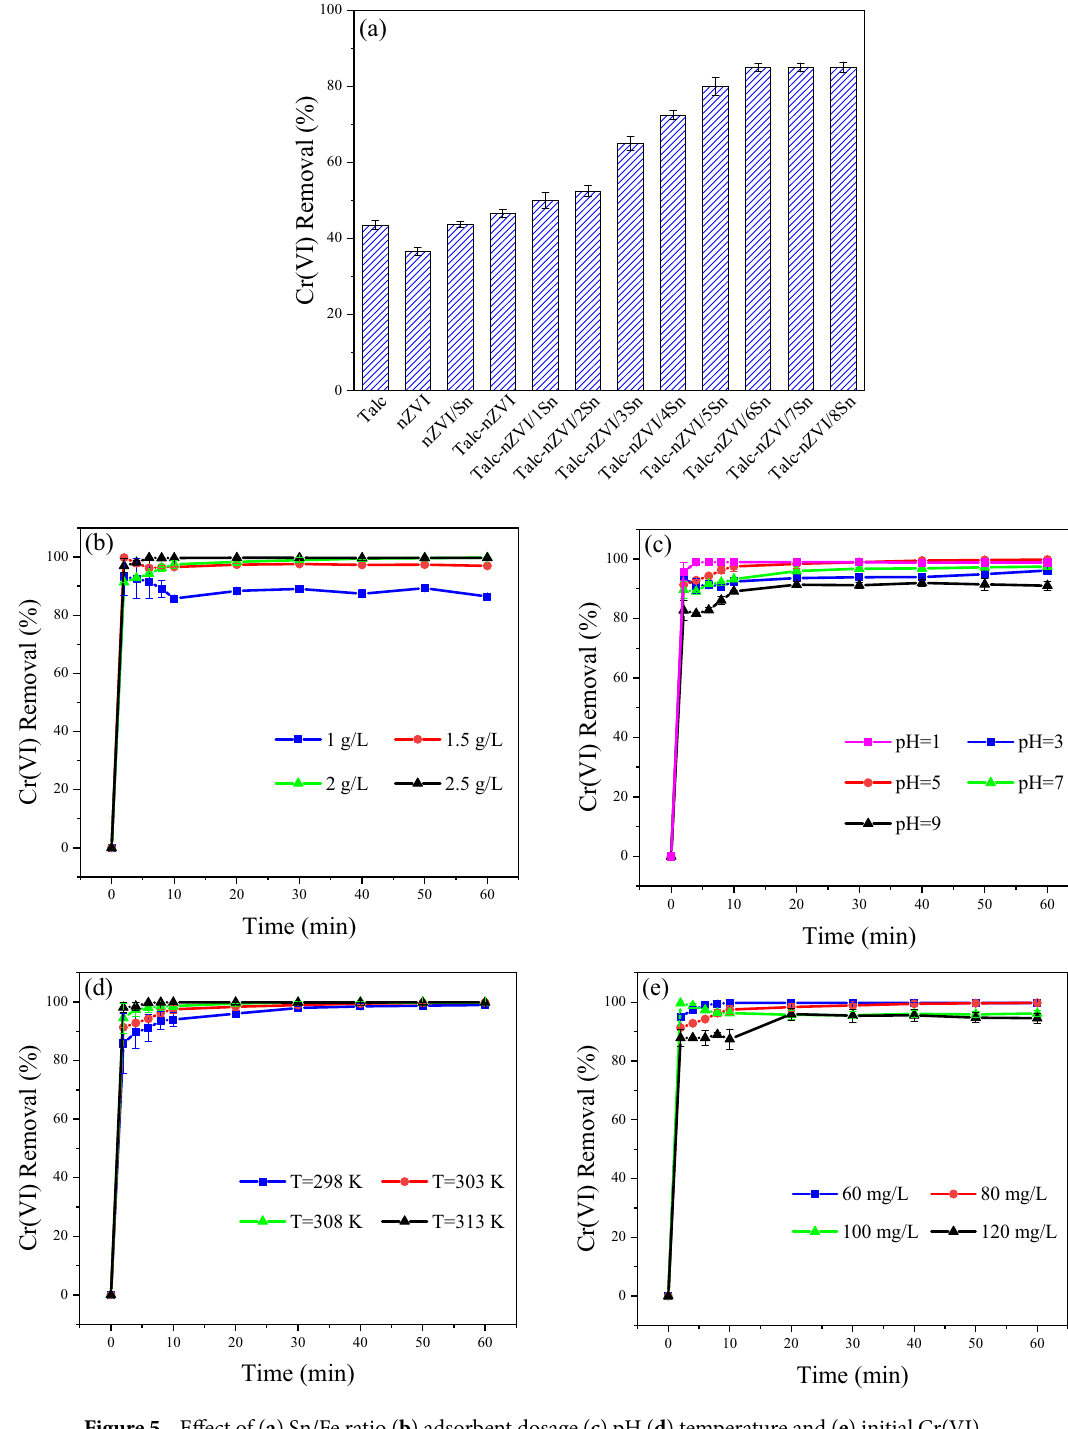
Figure 5. Effect of ( a ) Sn/Fe ratio ( b ) adsorbent dosage ( c ) pH ( d ) temperature and ( e ) initial Cr(VI) concentration on Cr(VI)